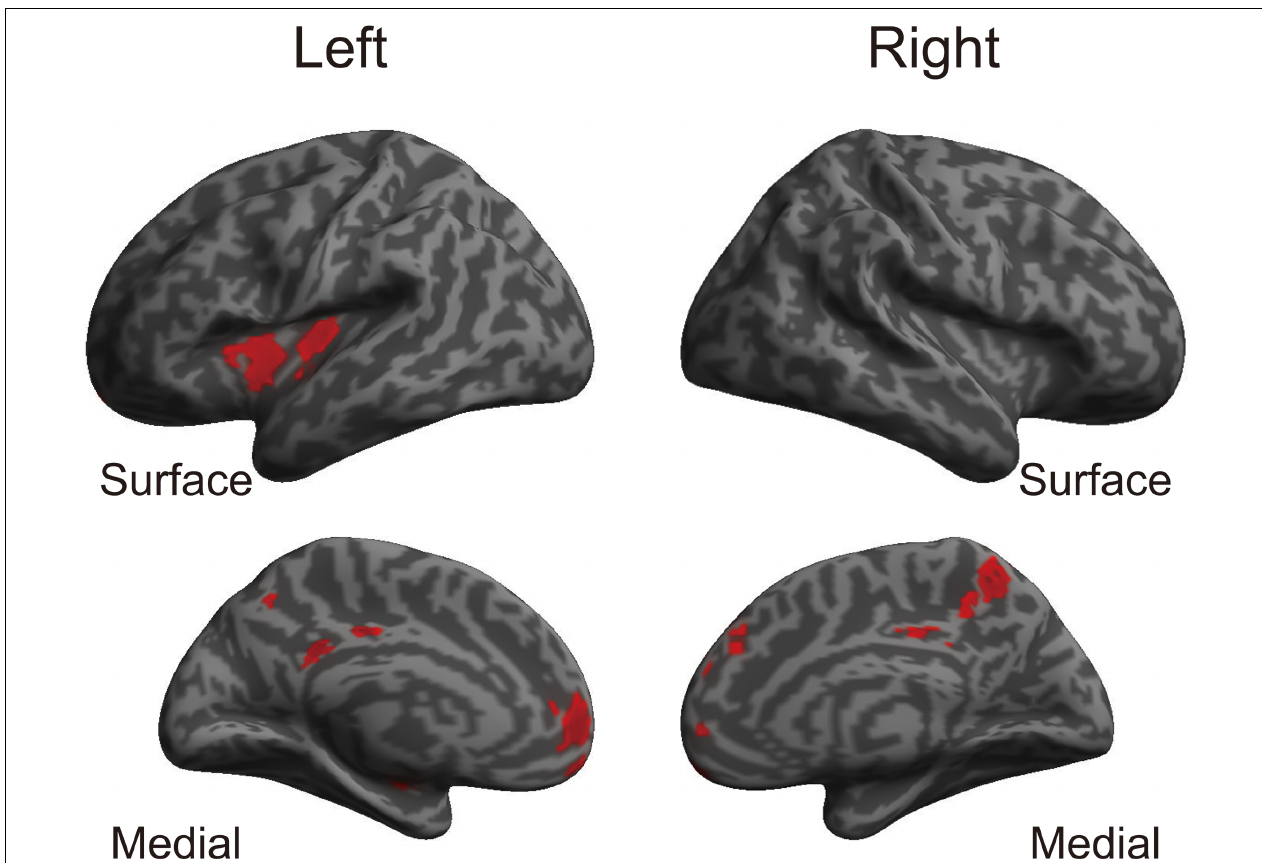
FIGURE 1 | Brain regions where athletes showed larger GMVs than non-athletes. Using a TFCE analysis, the athletes showed increased GMVs in various brain regions compared to the non-athletes. Table 4 shows the brain regions where the athletes showed gray matter enlargement. TFCE, threshold-free cluster enhancement; GMV, gray matter